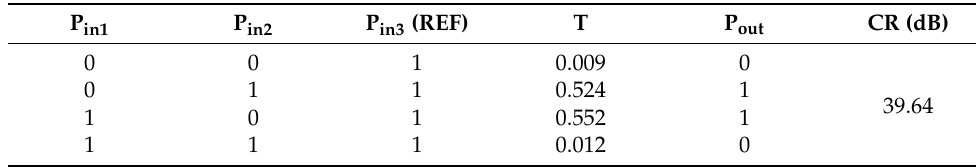
Table 1. Simulation findings for XOR (T th = 0.14).